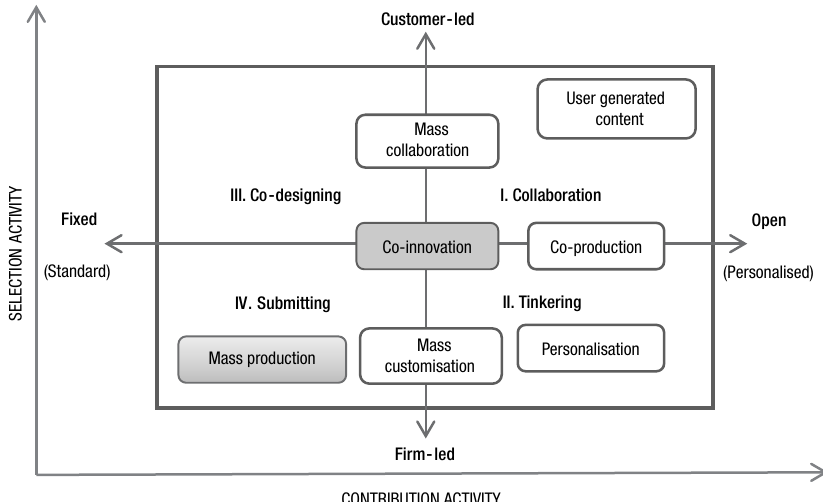
Fig. 1. Types of consumer value co-creation Source : adapted from Rindfleisch (2010) and Coates